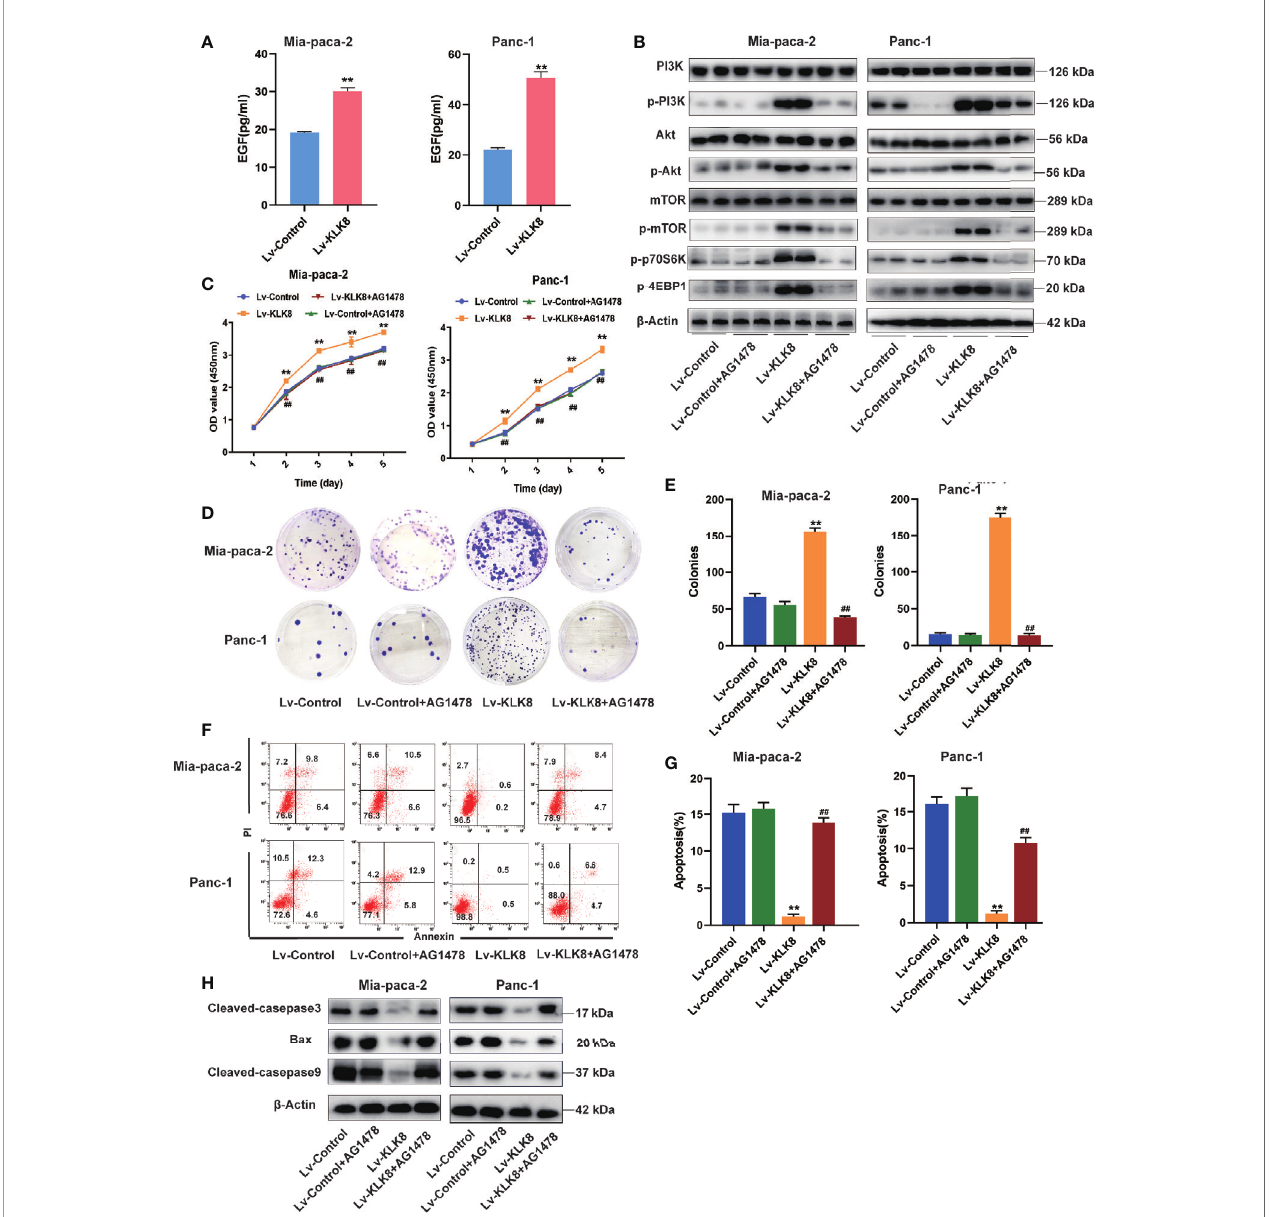
FIGURE 9 | EGF signaling contributes to KLK8-induced activation of PI3K-Akt-mTOR signaling pathway and KLK8-induced pro-proliferation and anti-apoptotic effects in pancreatic cancer cells. Mia-paca-2 and Panc-1 cells were treated with EGFR antagonist AG1478 (100 nM). Twenty-four hours later, cells were harvested for measuring cell protein level, proliferation and apoptosis. (A) Expression level of EGF in Mia-paca-2 and Panc-1 cells were evaluated by ELISA assay. (B) Levels of key proteins in PI3K-AKT-mTOR signaling pathways were examined in Mia-paca-2 and Panc-1 cells using western blot (C) Cell proliferation was detected by CCK8 assay in Mia-paca-2 and Panc-1 cells. (D) Colony formation was detected in Mia-paca-2 and Panc-1 cells. (E) Demonstrated the quanti fi ed data of cell colonies. (F) Cell apoptosis was determined by Annexin V-FITC and PI double staining analysis performed by fl ow cytometry. Representative fl ow cytometry images were shown. (G) Demonstrated the quanti fi ed data of cell apoptosis. (H) Pro-apoptotic markers cleaved caspase-3, cleaved caspase-9 and Bax assessed by western blot. Data were presented as the mean ± SEM (n=3). **p <0.01 vs Lv-control; p < 0.05, ## p < 0.01 vs